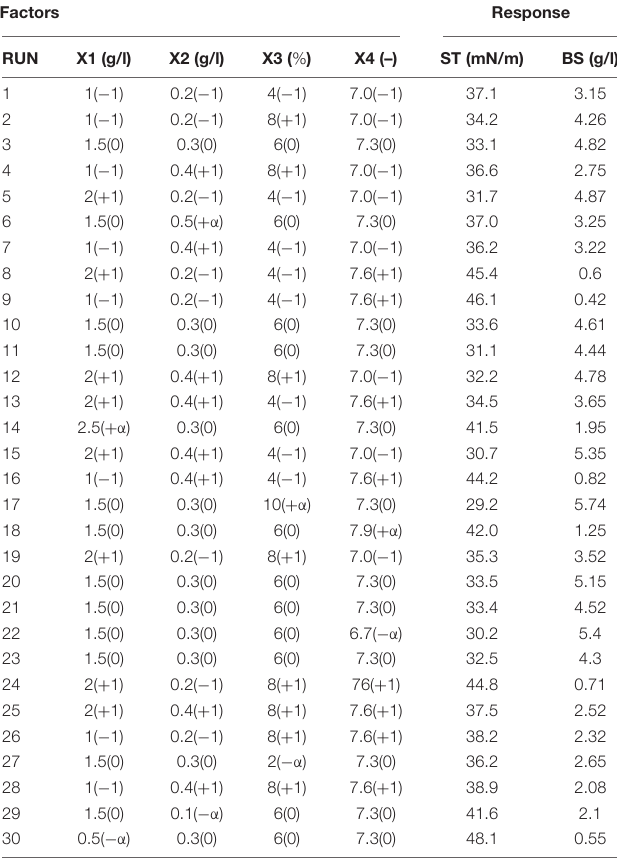
TABLE 3 | Central composite design (CCD) experiment matrix for two response variables of surface tension (ST) and produced biosurfactant (BS).